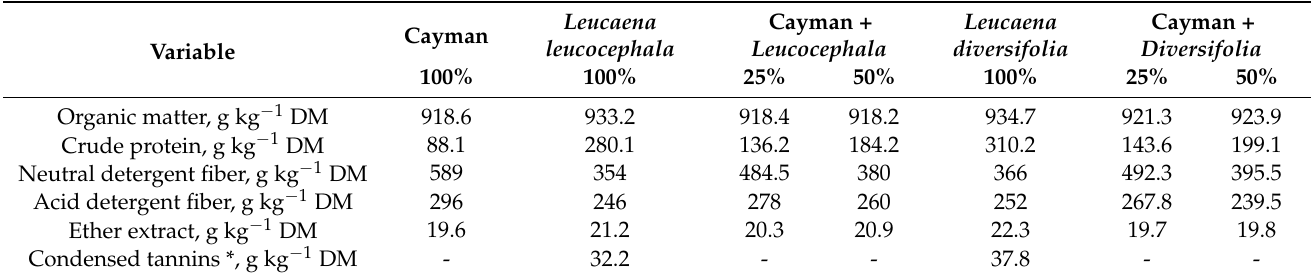
Table 1. Nutrients and condensed tannins content in the diets utilized for the in vitro incubations. Cayman: Urochloa hybrid cv. Cayman (CIAT BR02/1752); leucocephala : Leucaena leucocephala CIAT 17263; diversifolia : Leucaena diversifolia ILRI